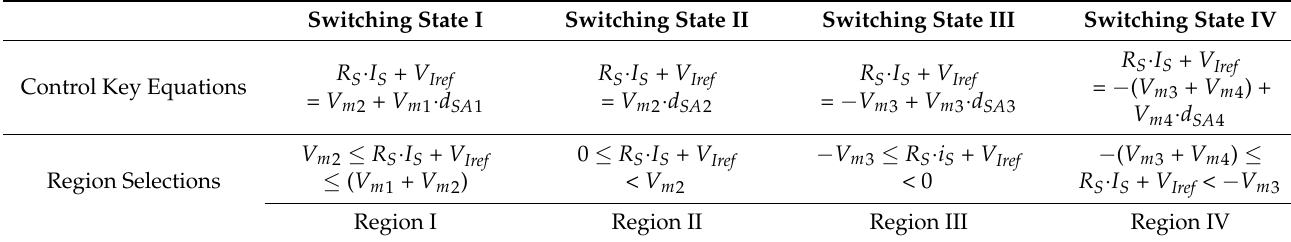
Table 2. Control key equations for four operation regions.